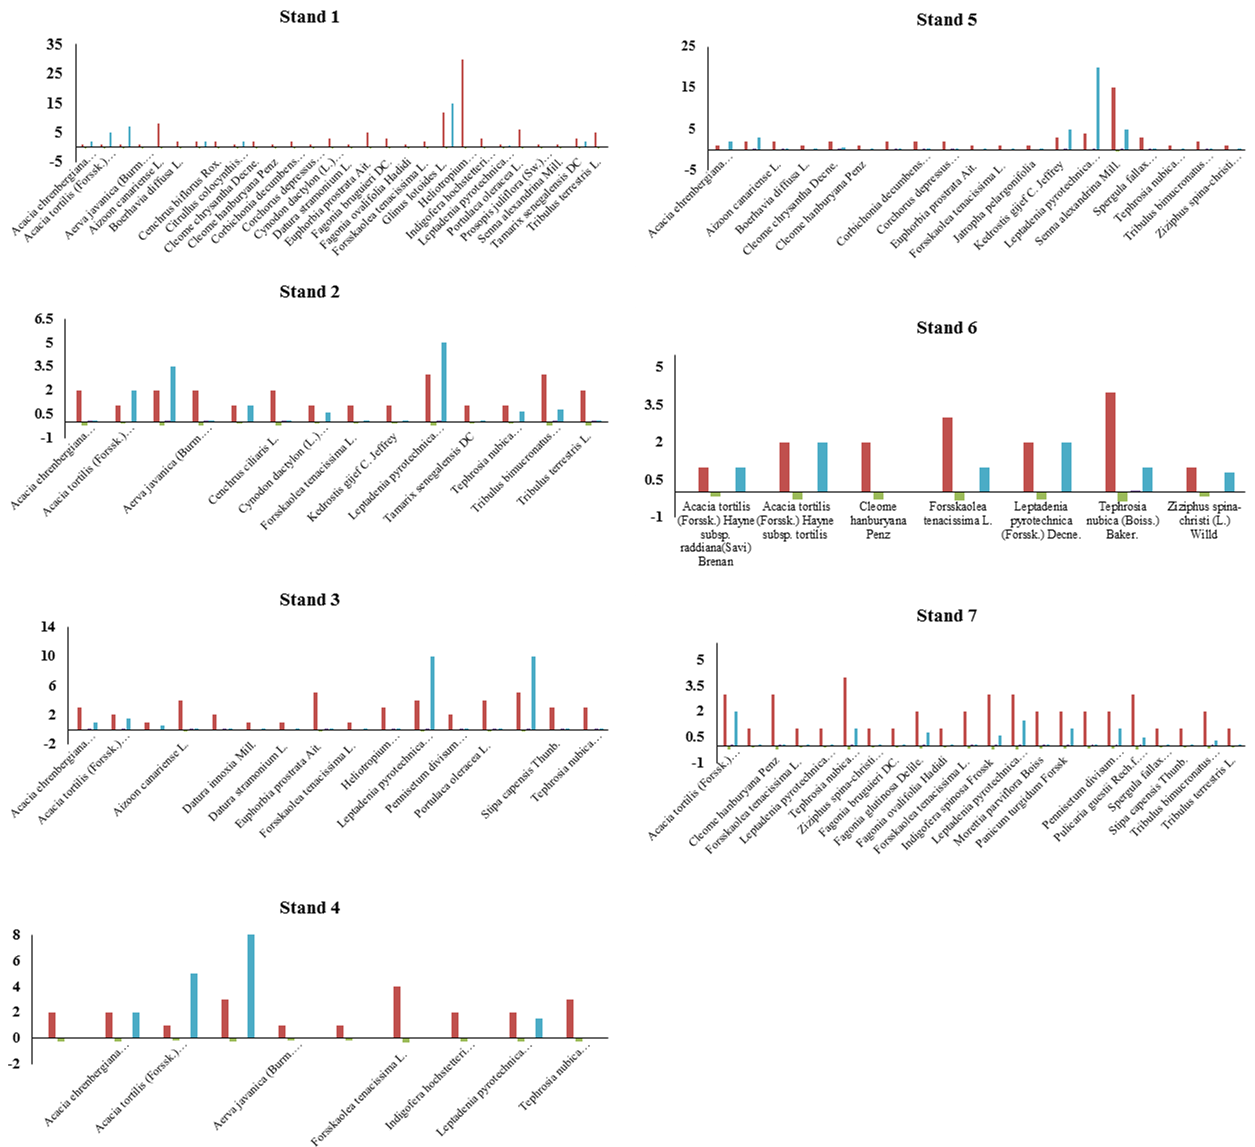
Figure 5. Floristic diversity at the studied